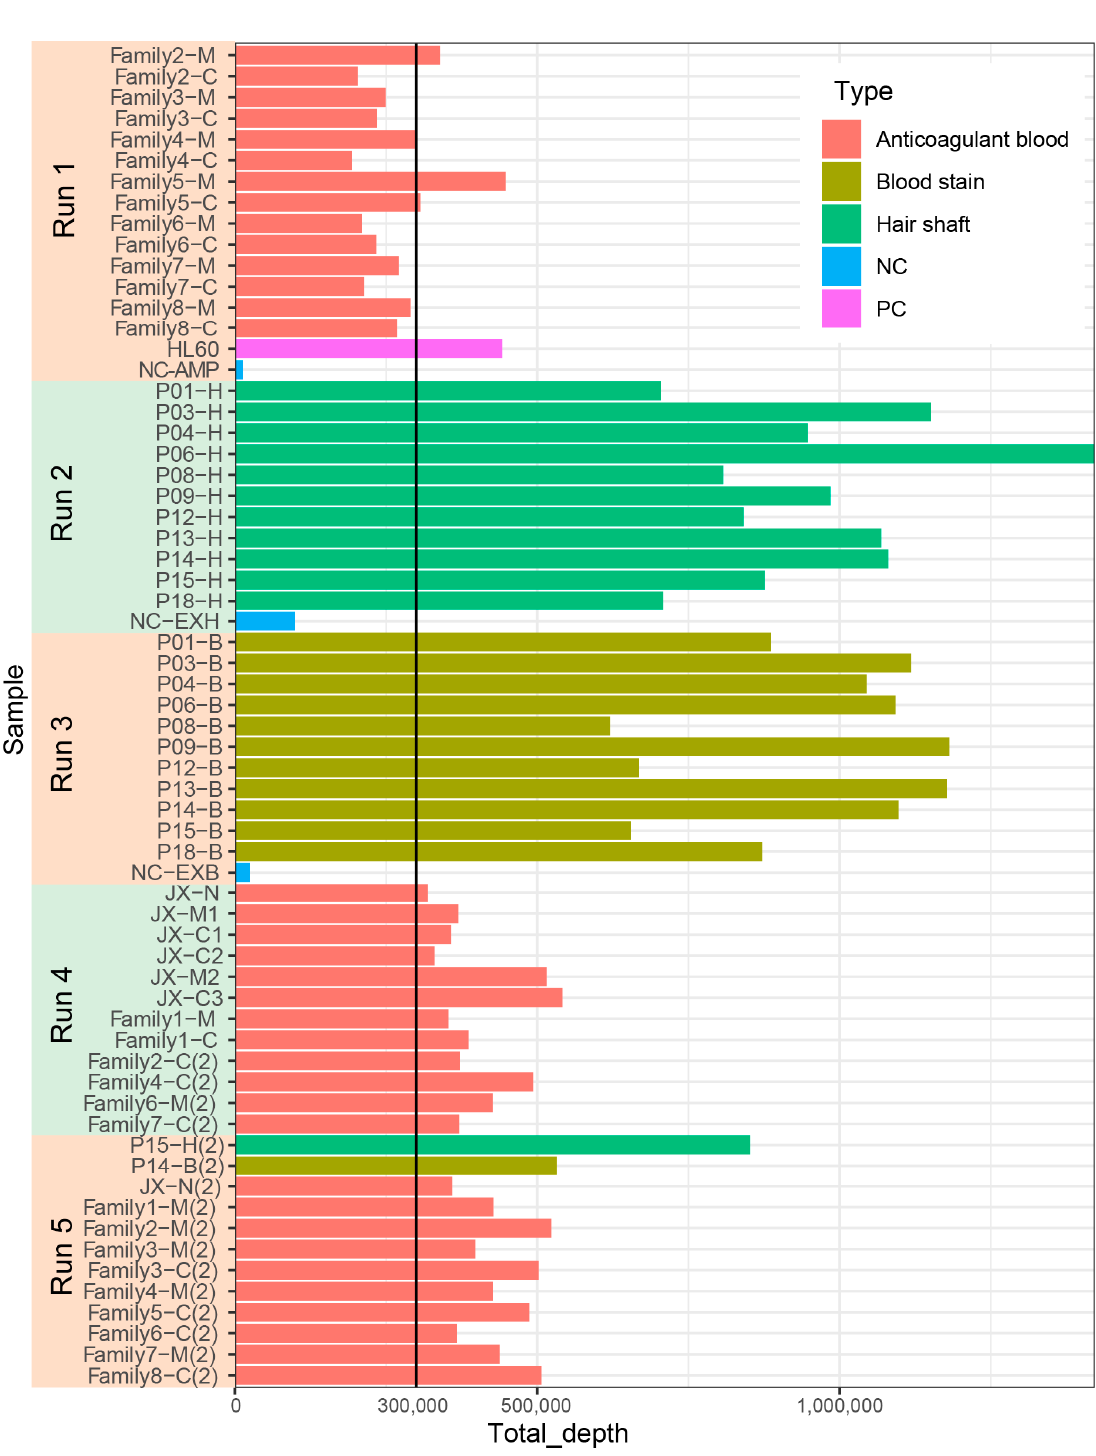
Figure 1. Total read depths of the sequenced libraries. ‘M’ represents mother in the family pair, ‘C’ represents offspring in the family pair, ‘H’ represents hair shaft, and ‘B’ represents blood sample. Sample IDs with ‘(2)’ correspond to the twice-sequenced libraries. The vertical ‘300,000 ′ line is the threshold of total read depth recommended by the manufacturer as a guarantee of complete mtGenome coverage.